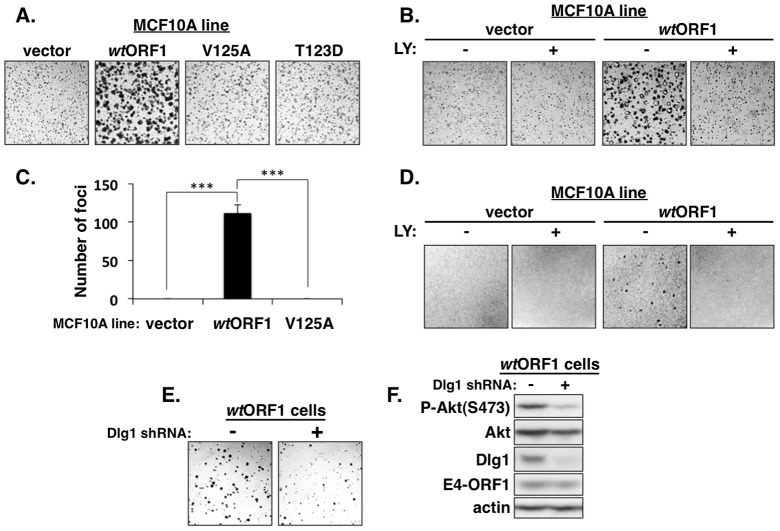
E4-ORF1 induces PBM-, PI3K-, and Dlg1-dependent cellular transformation.(A) WtORF1 cells but not vector, V125A, or T123D cells grow in soft agar. The indicated MCF10A lines were analyzed in soft agar assays as described in the
Materials and Methods
. Cells were photographed 5 days post plating. (40× magnification) (B) LY294002 (LY) inhibits soft agar growth of wtORF1 cells. Soft agar assays were performed as in (A), except the culture medium contained either 100 µM LY (+) or DMSO vehicle (−) from 3 days post plating until the experiment was ended at 10 days post plating, when cells were photographed (40× magnification). (C) WtORF1 cells but not vector or V125A cells form foci in monolayer cultures. The indicated MCF10A lines were analyzed in focus formation assays as described in the
Materials and Methods
. Foci were counted at 22 days post plating. The experiment was done in triplicate, and bars indicate the mean ± SD (p-value<1.0E-08). (D) LY inhibits focus formation by wtORF1 cells. Focus formation assays were performed as described in (C), except a mixture of 150 wtORF1 or vector cells and 1×105 vector cells was seeded into each well. From 6 days post plating until the experiment was ended at 21 days post plating, cells were cultured in complete medium containing 100 µM LY (+) or the same volume of DMSO vehicle (−). Cells were stained and photographed. Panels show a representative 2.4 cm×2.4 cm square region of each cell monolayer. (E) Dlg1 depletion decreases the growth of wtORF1 cells in soft agar. Soft agar assays were performed as in (A), except wtORF1 cells stably transduced with pSUPER-Dlg1 shRNA (+) or pSUPER-Dlg1 scrambled control shRNA (−) were analyzed and 10-times fewer cells were plated into culture medium containing a sub-inhibitory dose of LY (25 µM). Cells were photographed at 22 days post plating (40× magnification). (F) Control immunoblot assays for panel E compare expression of the indicated proteins in the MCF10A lines treated for 30 min with 25 µM LY.